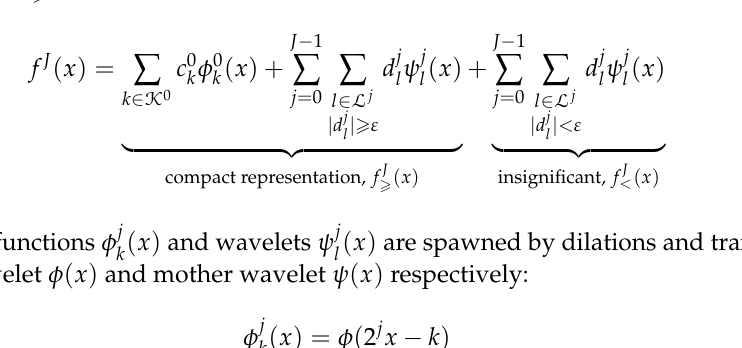
Figure 6. Scaling function coefficients c 0 1 . . . 5 are represented by wavelet coefficients d j